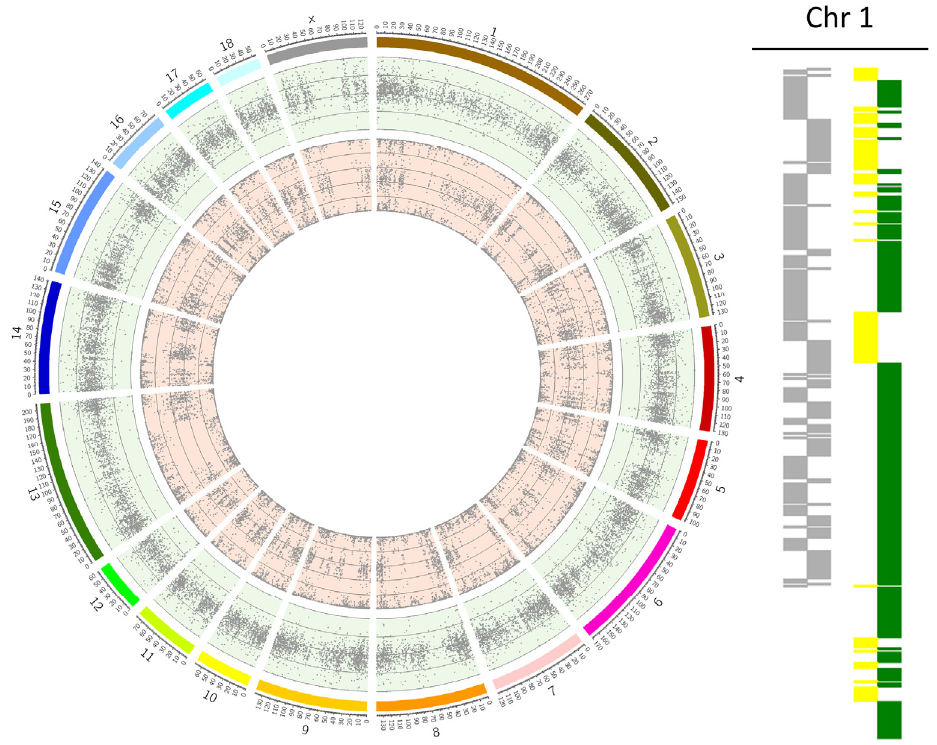
Figure 2. Example of a parthenogenetic case in an in vitro porcine embryo. In the circle graph with BAF and LRR plots, all chromosomes present as disomic with BAF showing plots for the three allele combinations (AA, AB, and BB) and LRR plots around zero. The figure on the right shows how the chromosomes look like all over the genome on the Karyomapping (chromosome 1 was used for example). Here, it is noticeable that there is an absence of haploblocks in the paternal block (where it should be blue/red, there is only grey block—missing information) and the maternal block shows a higher change of haploblocks through the chromosome, which demonstrates the extra information in this chromosome.